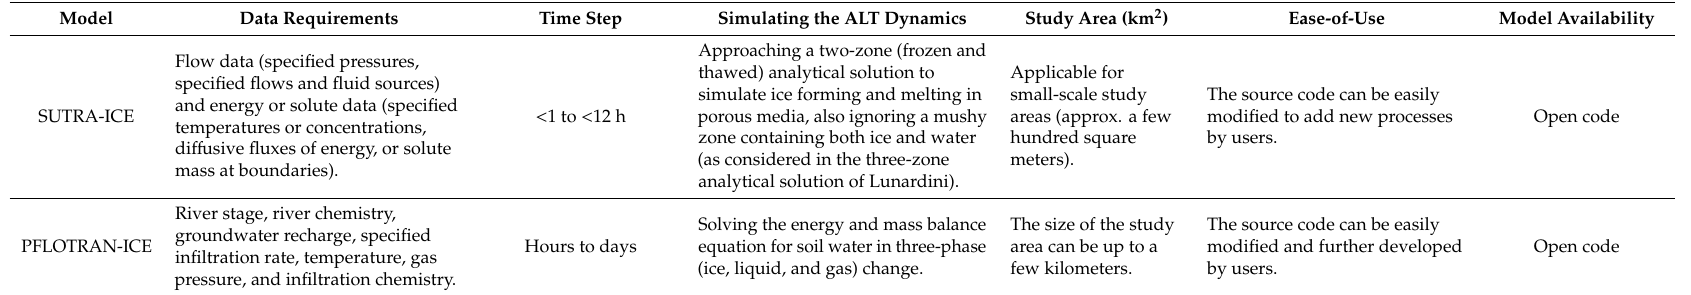
Table 5. Summarization of model comparisons